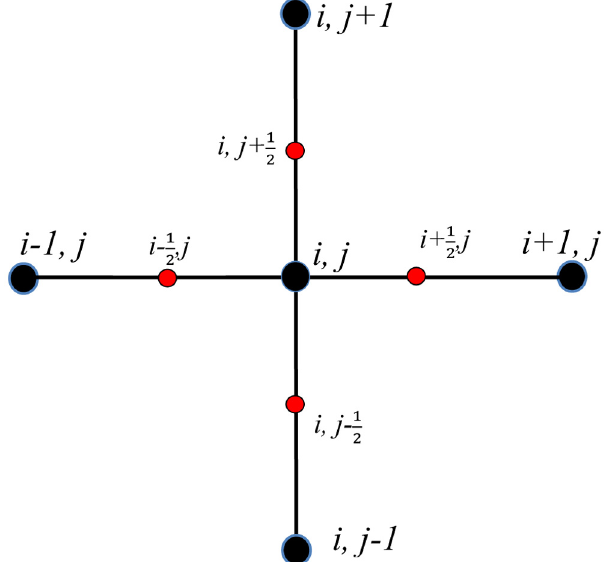
Fig. A2. Computational molecule (stencil) used for the generation of the Jacobian matrix coef fi cients by forward fi nite difference